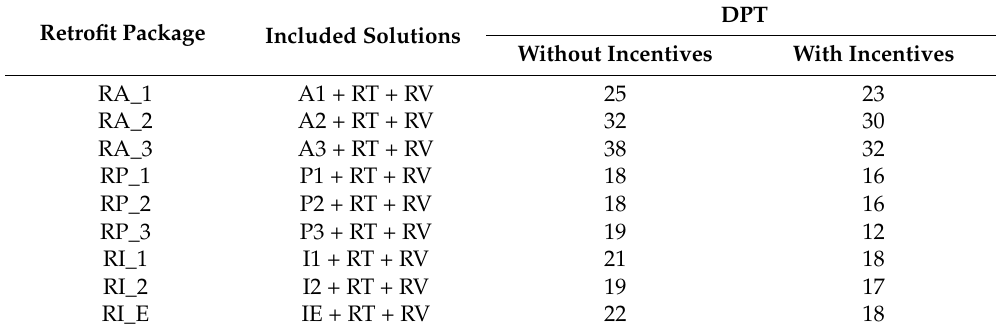
Table 6. Discounted Payback Time of the proposed retrofit packages with and without incentives. Retrofit Package Included Solutions